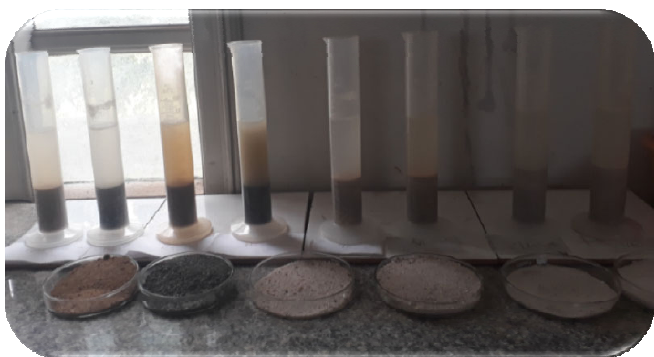
Figure 5. Free swell analysis of sand samples.